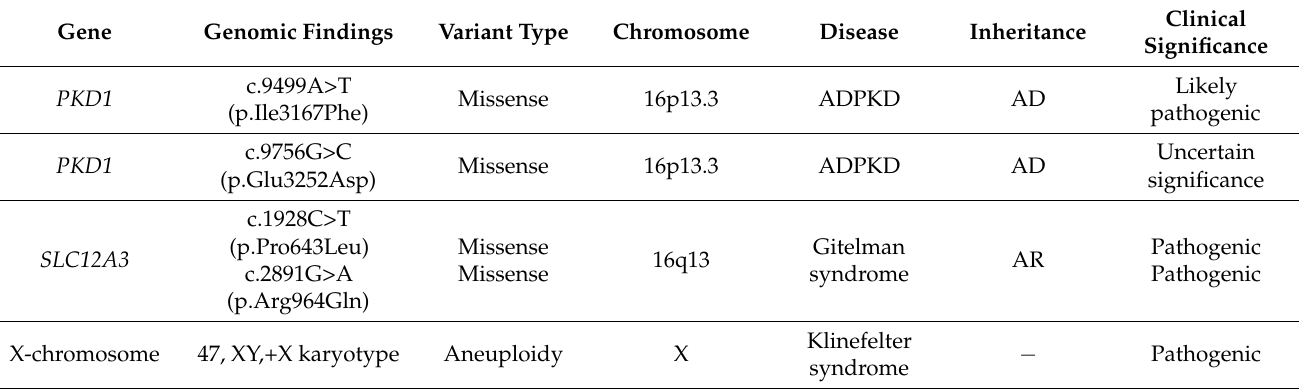
Table 3. Summary of the genetic findings that may be associated with clinical features on the